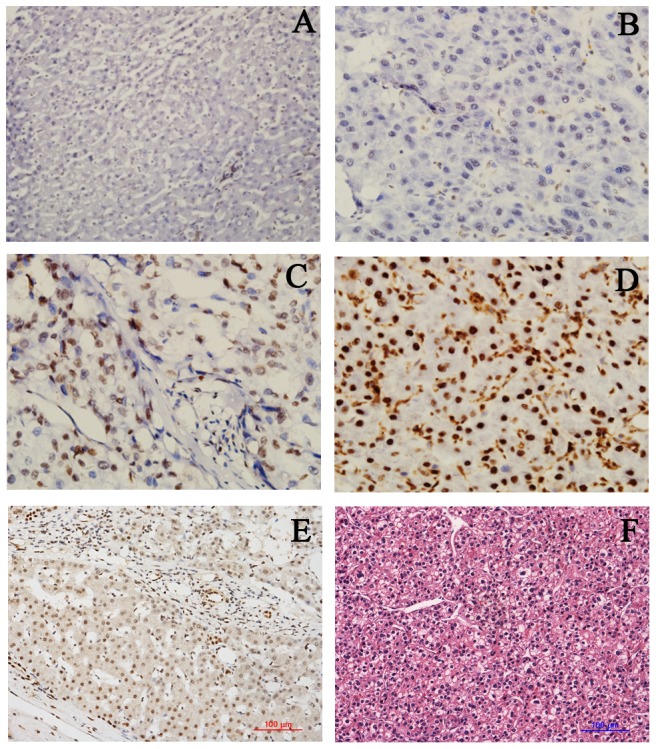
Expressions of HMGB1 in HCC tissues and surrounding non-cancerous tissues.(A) Negative expression in distant normal liver tissue (IHC ×200). (B) Weak expression in HCC tissues (IHC ×400). (C) Moderate expression in HCC tissues (IHC ×400). (D) Strong expression in HCC tissues (IHC ×400). (E) Weak expression in cirrhotic liver (IHC ×200). (F) HCC tissue (HE ×200).